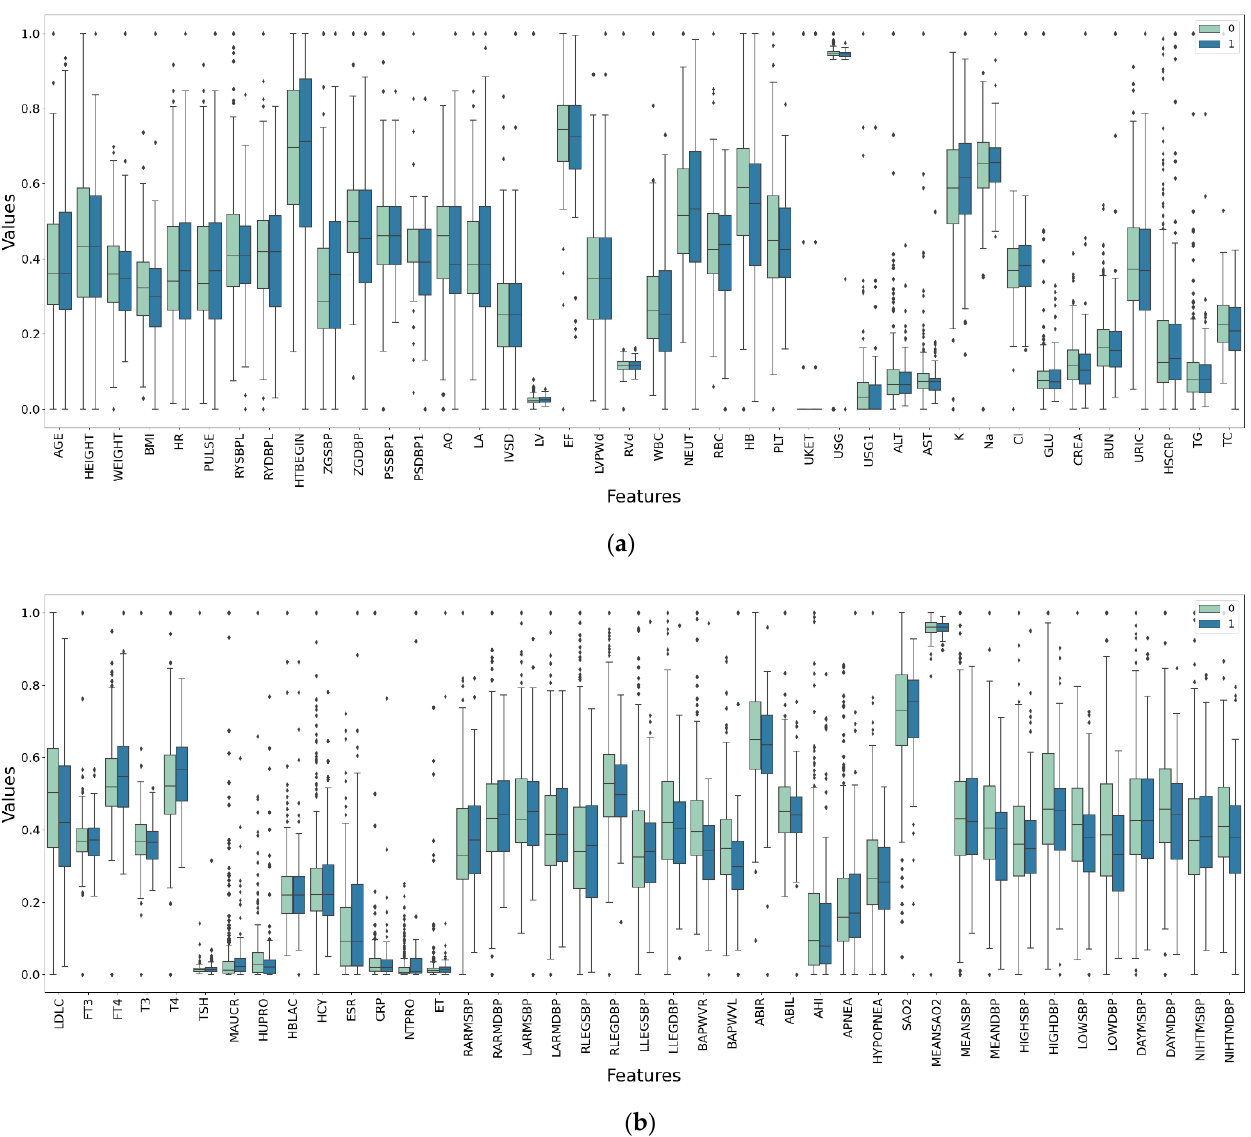
Figure 9. Box plot of medical data after preprocessing. ( a ) The first 40 features. ( b ) The last 41 features.